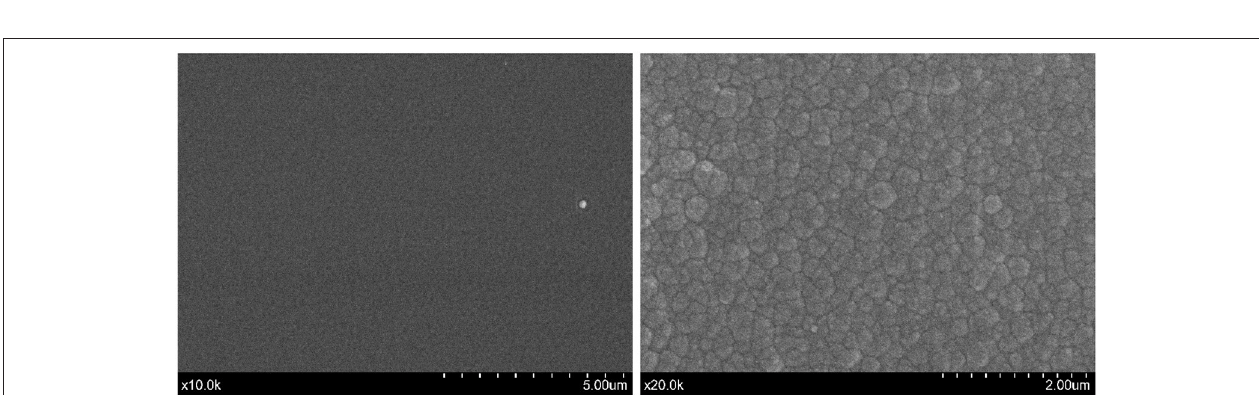
FIGURE 7 | The SEM images. (Left) the a-C (bias) sample. (Right) the a-C sample.